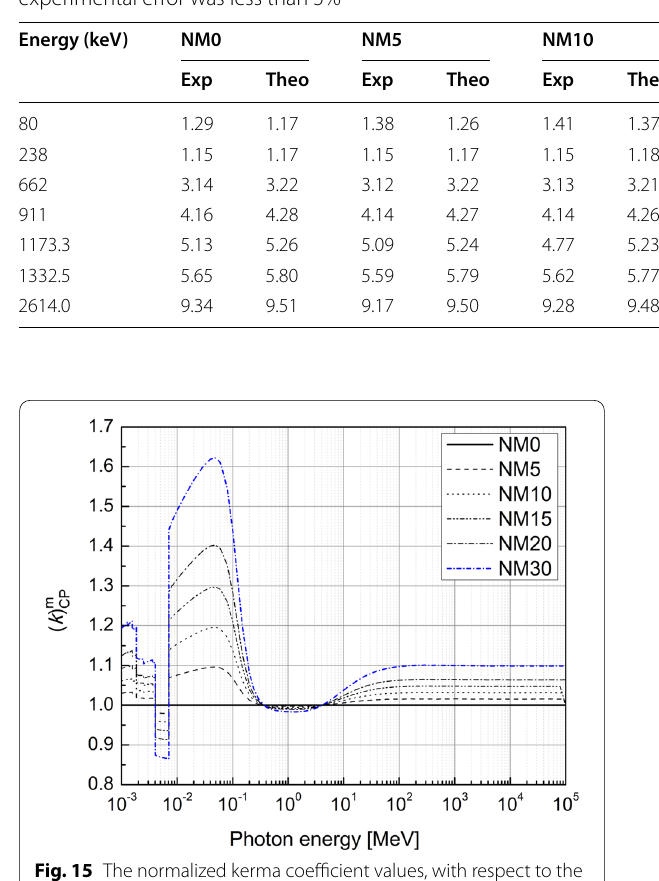
O nanoparticles. The 3 4